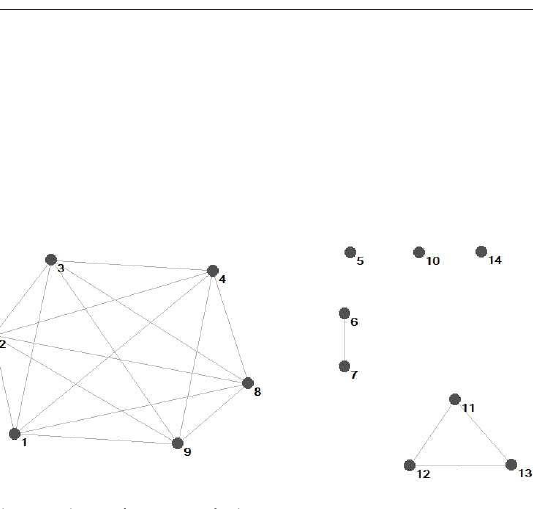
Fig.4. Simon's network in